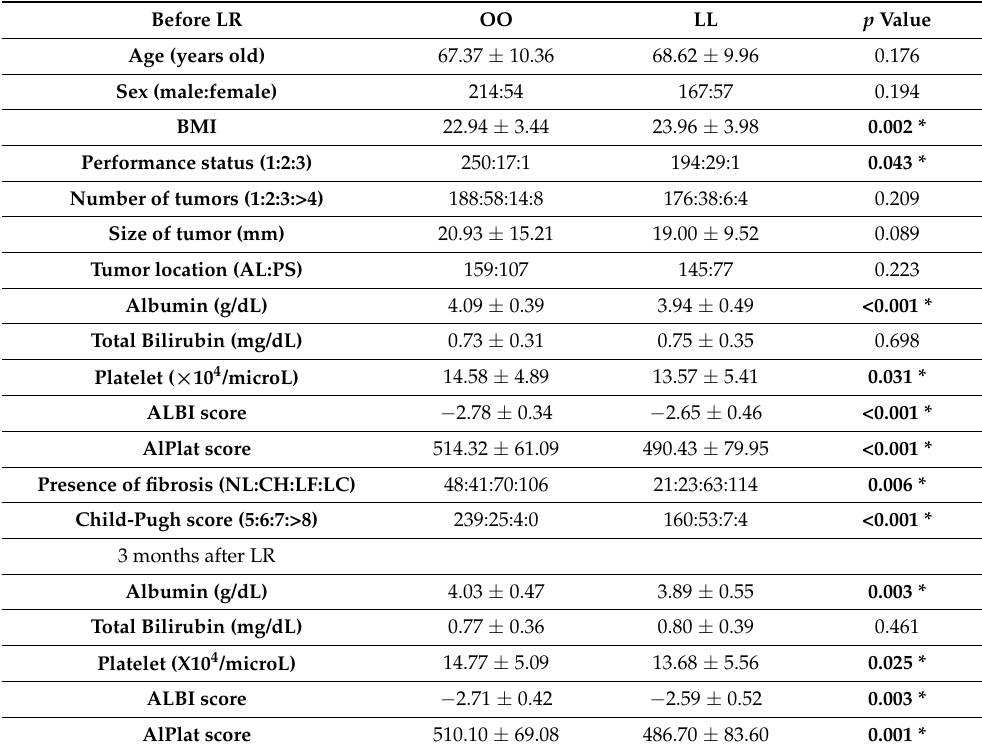
Table 3. Comparison between OO group and LL group: Background factors, indicators for liver function before RLR, and after